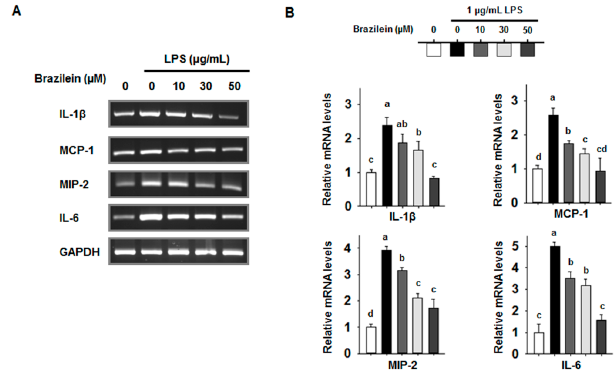
Figure 2. The transcription levels of interleukin (IL)-1 β , MCP-1, macrophage inflammatory protein-2 (MIP-2), and IL-6 were decreased by brazilein in LPS stimulated Raw264.7. Cells were pre-incubated with 10, 30 and 50 μ M brazilein for 1 h, treated with 1 μ g/mL LPS, and incubated for a further 24 h. DMSO was used as a vehicle. ( A ) Total RNA was amplified by RT-PCR using the indicated primers for IL-1 β , MCP-1, MIP-2, and IL-6; ( B ) The relative fold changes in mRNA levels were quantified using the ImageJ program. The data are expressed as mean ± standard deviations (SD), ( n = 3). Values with different letters are significantly different, p < 0.05.